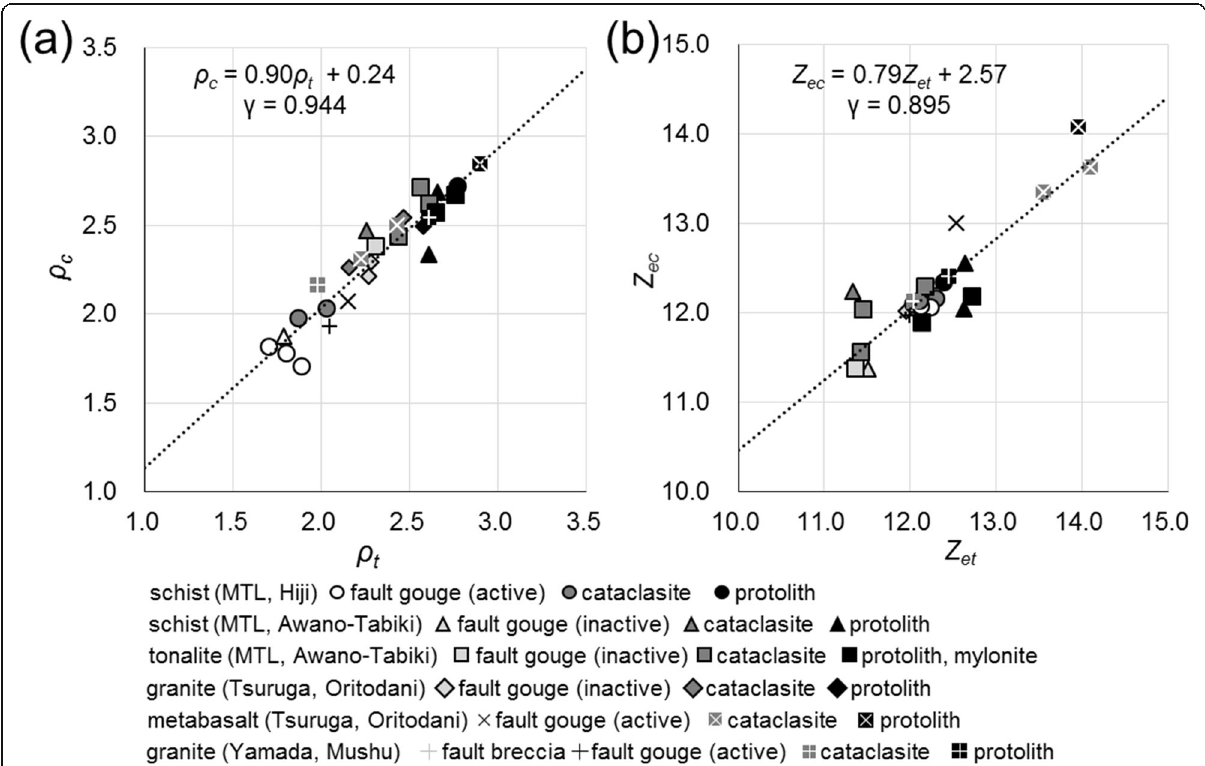
Fig. 11 Crossplots of a the real density, ρ t , versus the measured density, ρ c , which is calculated from N CTM , and b the real effective atomic number, Z et , versus the measured effective atomic number, Z ec , which is calculated from N CTM . Regression lines were determined via least-squares